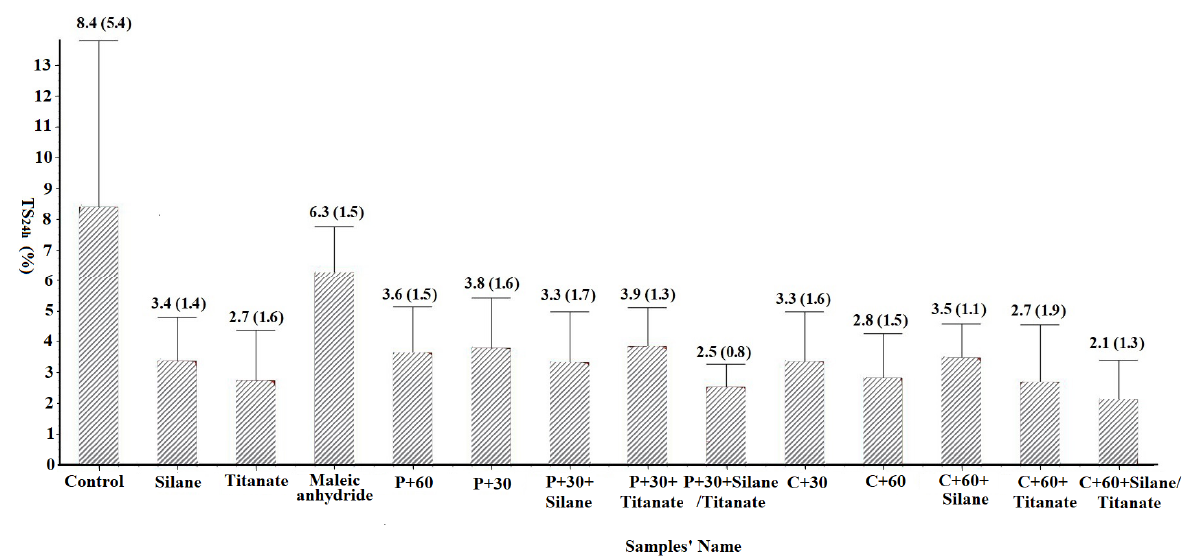
Figure 2. Effect of pectinase or cellulase pretreatment of a 70:30 hemp hurd/wood mixture on thickness swelling (TS) of composites manufactured using these materials and polypropylene. Values represent means of 10 replicates/test. Values in parentheses represent one standard deviation; C = cellulase, P = pectinase, and 30 or 60 represent exposure times in minutes.